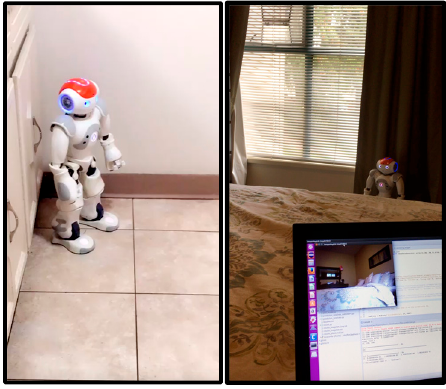
Figure 5. NAO humanoid robot during experiments.